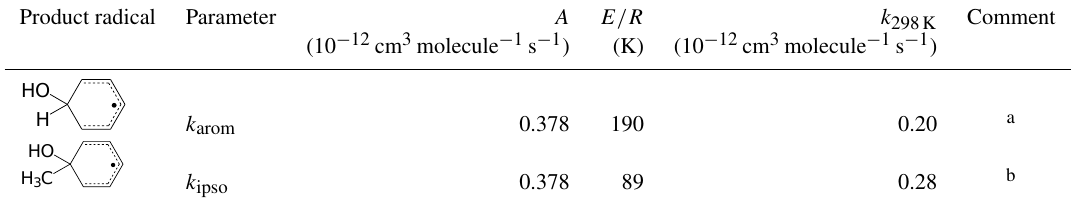
Table 2. Group rate coefficients for OH addition to carbon atoms in monocyclic aromatic rings, and their temperature dependences described by k = A exp ( − (E/R)/T ) . Parameters are shown for addition to an unsubstituted carbon ( k arom ) and to a methyl-substituted carbon ( k ipso